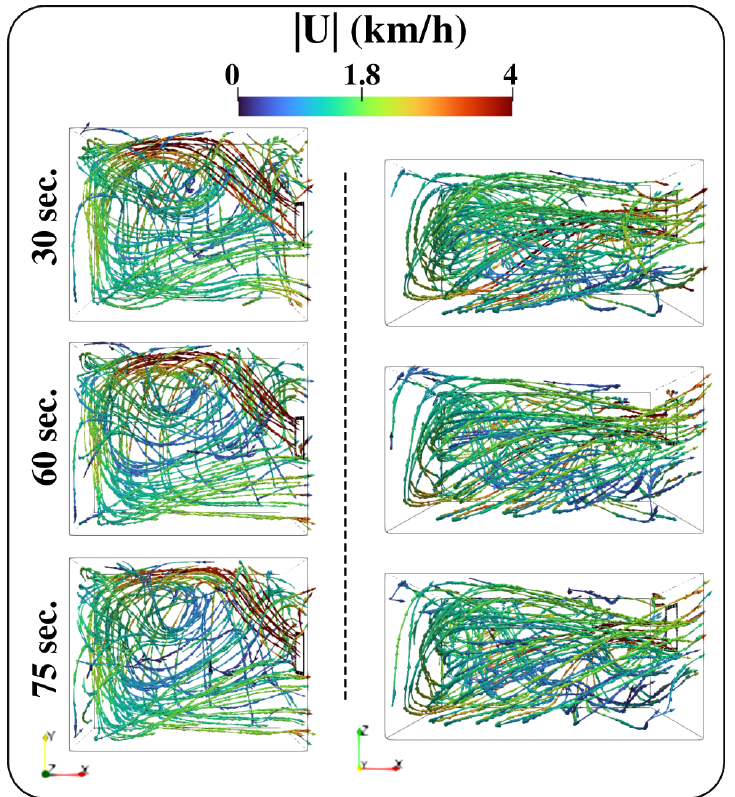
Figure 4. Indoor streaklines at different times coloured by the velocity magnitudes, and showing the window and the velocity vectors directions. Case: Natural ventilation due to a low wind speed out- doors U = 4 km/h and a lower outdoor temperature, walls-particles-interaction: stick . Left hand side Column: XY-plane perspective view; Right-hand side Column: XZ-plane perspective view.